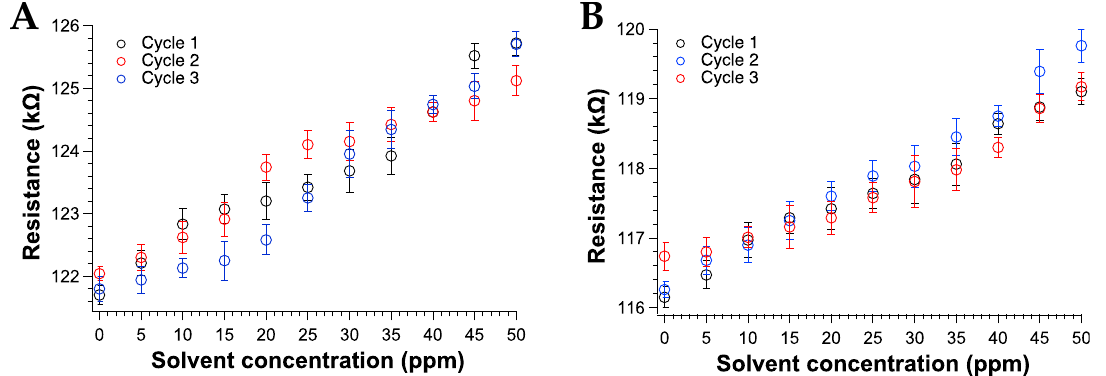
Figure 10. Responses curves of the TPSA-RGO based-sensors as a function of ( A ) THF ( B ) CHCl 3 vapors concentration (ppm).